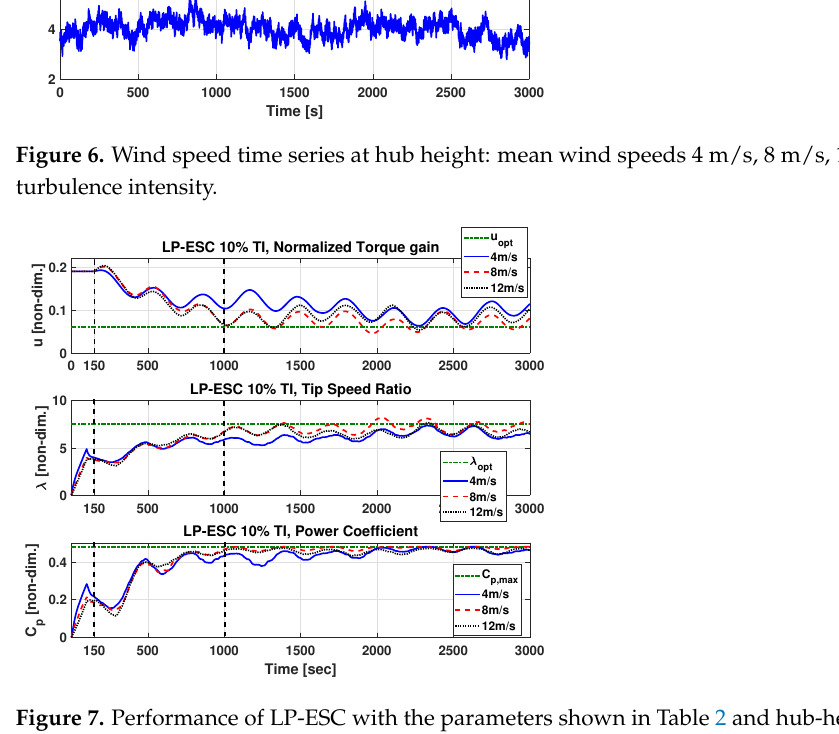
Figure 7. Performance of LP-ESC with the parameters shown in Table 2 and hub-height wind from Figure 6. Normalized torque gain u ( top ), tip speed ratio λ ( middle ), estimated power coefficient C p ( bottom ). The dashed horizontal lines indicate optimal parameters u opt , λ opt and C P ,max . Ver- tical dashed lines in u show the point LP-ESC is turned on (150 s) and the point where it reaches practical convergence.